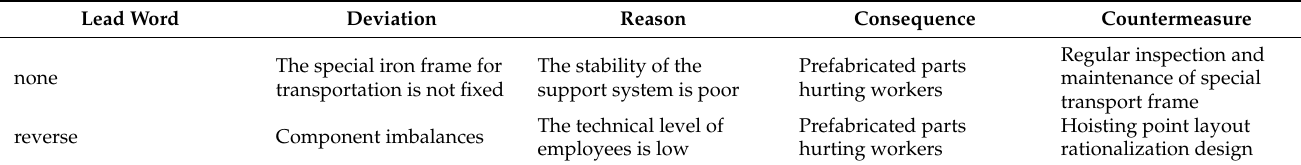
Table 7. HAZOP analysis of the components loading and unloading